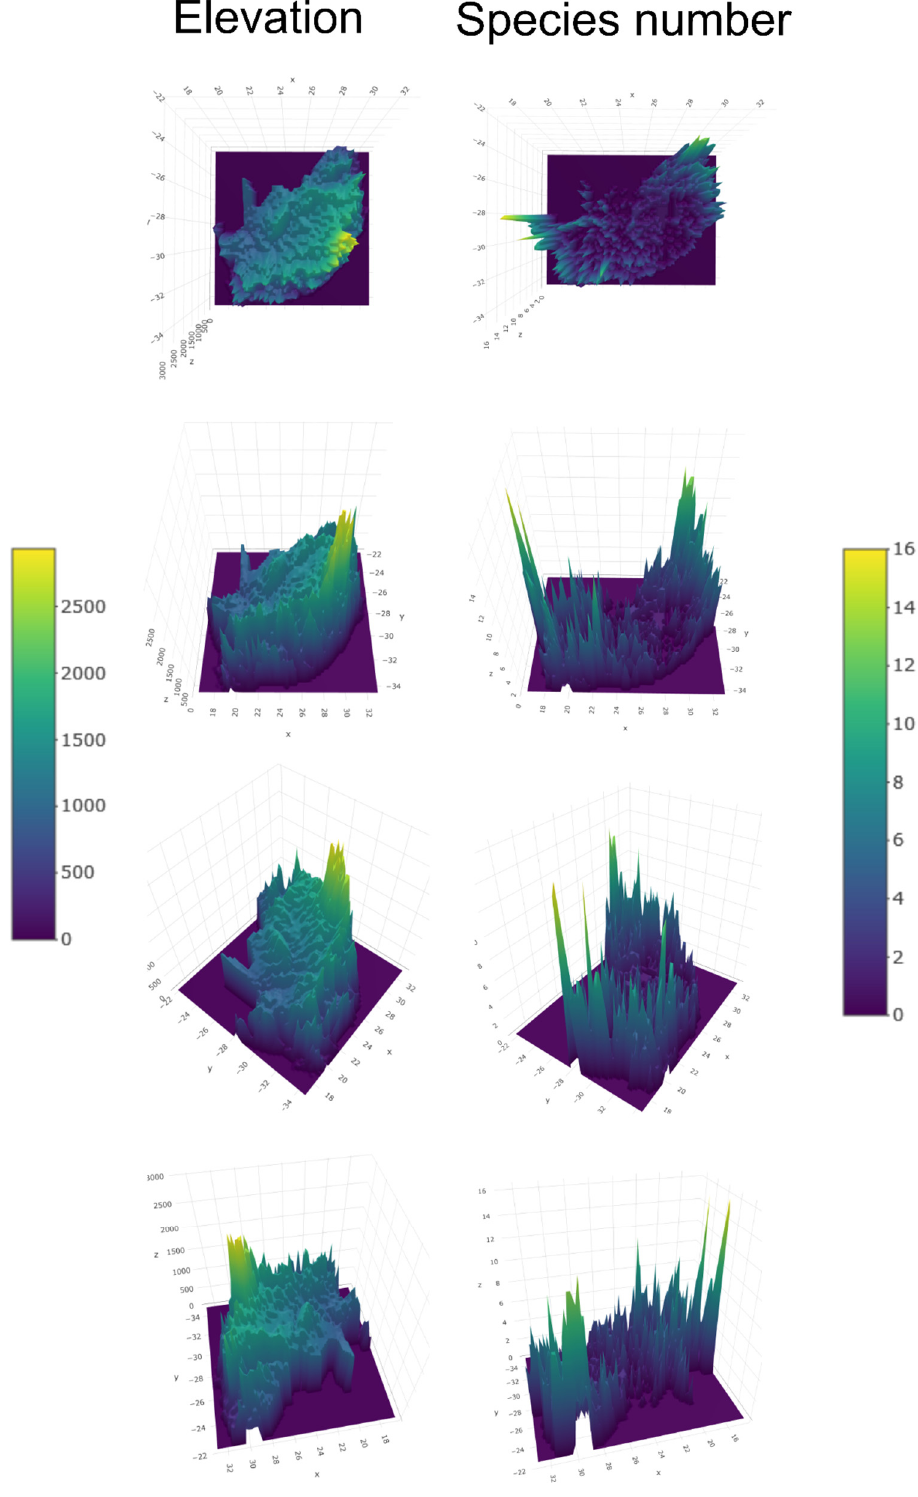
Figure 3. Surface plots of the elevation ( left ) and gekkonid species numbers ( right ) at each QDGS centroid position for the countries of South Africa, Lesotho, and Eswatini. These 3D surface plots are viewed from above (1st plots), the south (2nd plots), the west (3rd plots), and the north (4th plots).